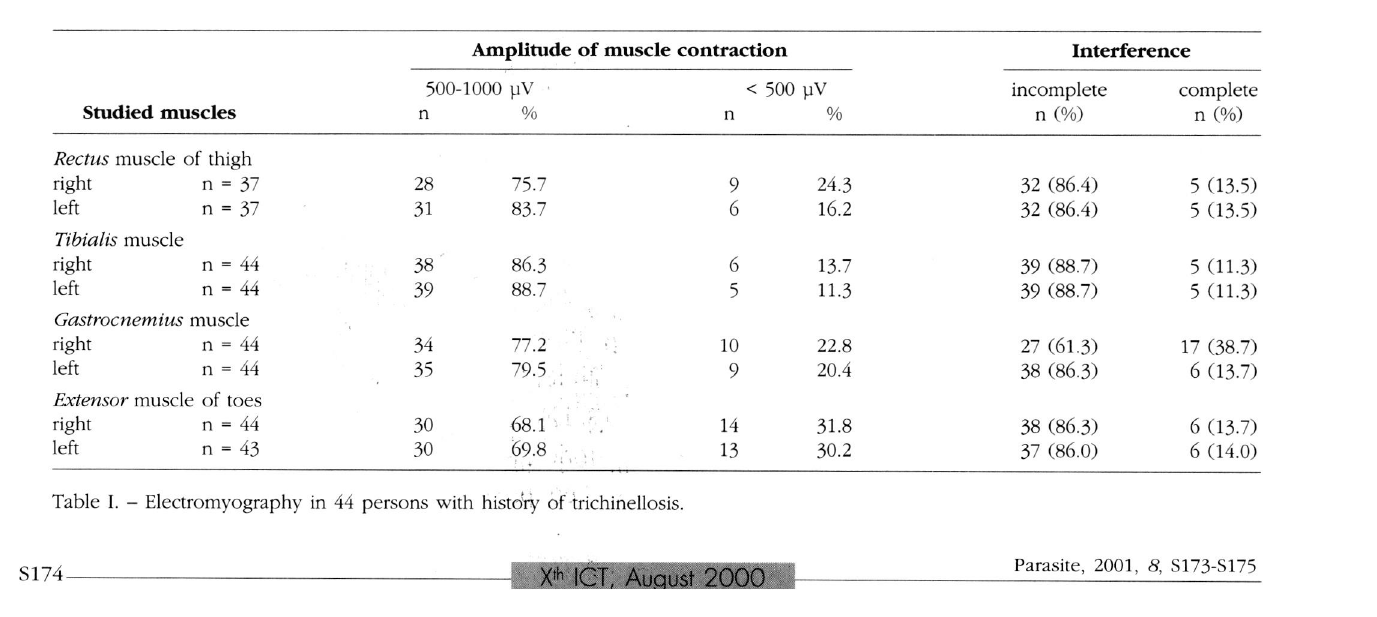
Table I. - Electromyography in 44 persons with history of